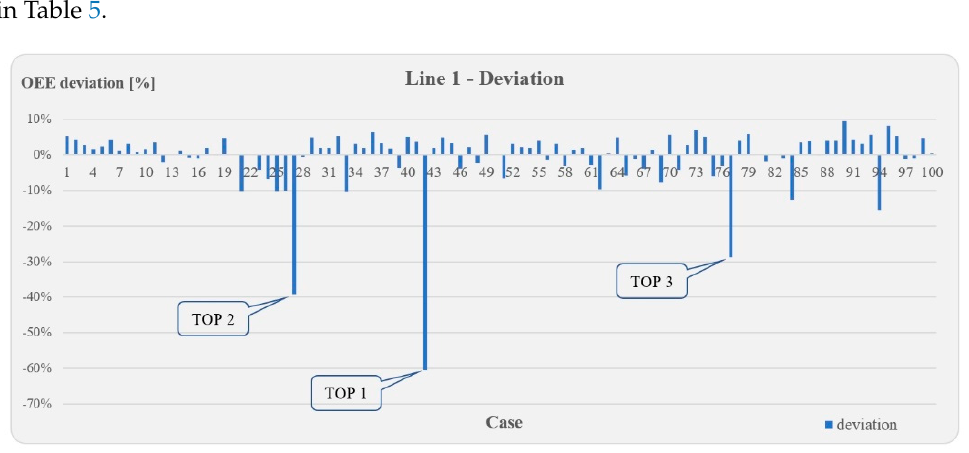
Figure 5. Deviation from the estimation for assembly line 2. The reasons for the TOP 3 negative differences for the two assembly lines are shown in Table 5. Table 5. TOP 3 deviation. Assembly Line 1